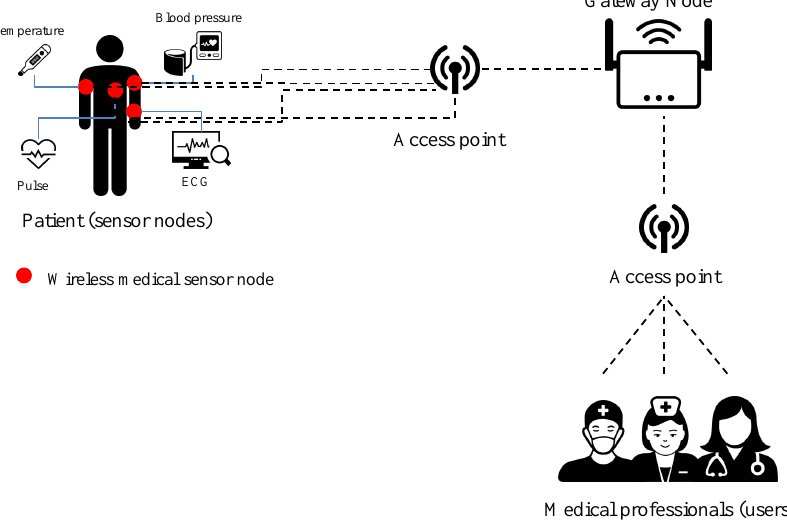
Figure 1. The proposed system